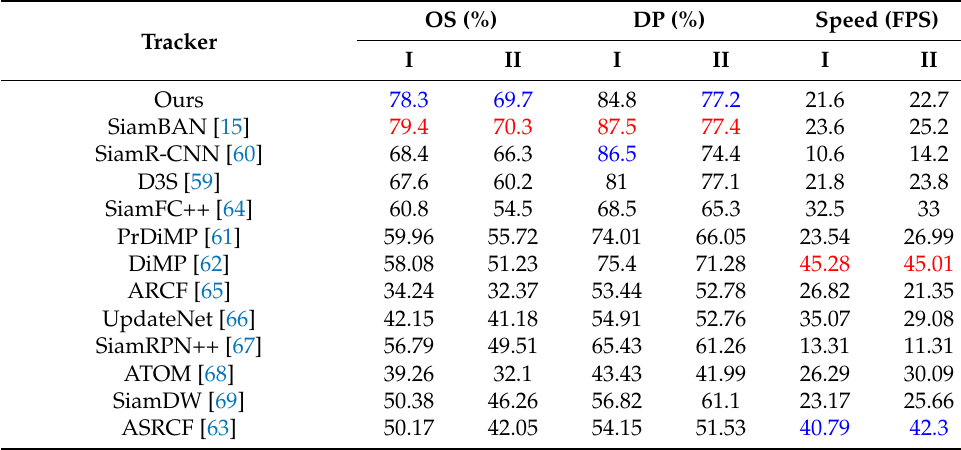
Table 1. Total performance on the OTB-50 (I) and OTB-100 (II)